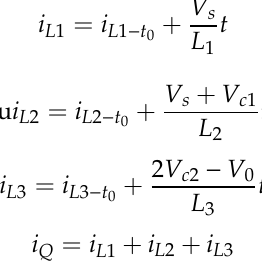
Figure 4. State-I.